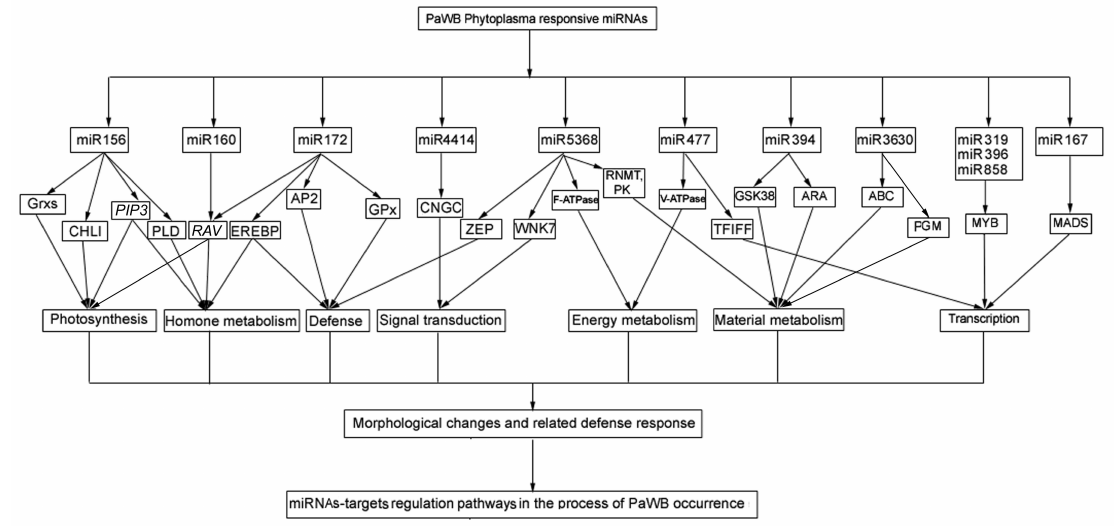
Figure 3. The potential regulatory network of the DEMs-target